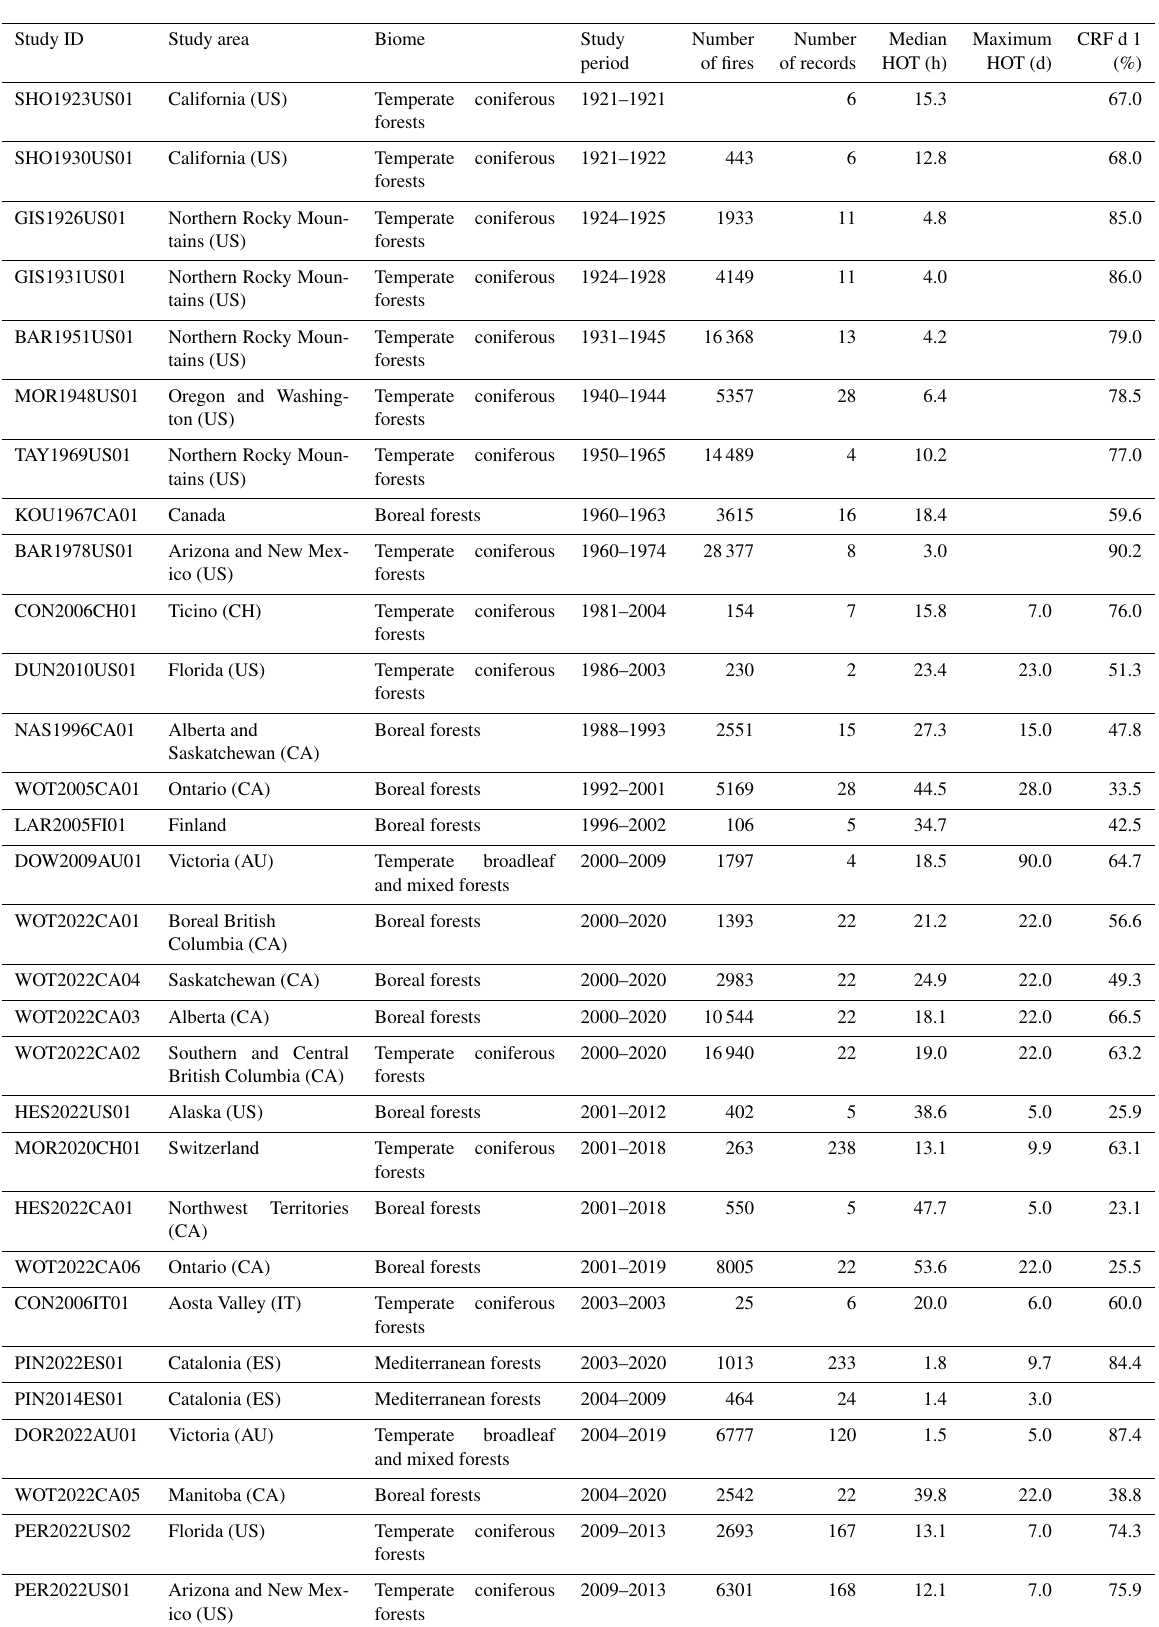
Table 3. Summary of the censored data from the database on holdover time of